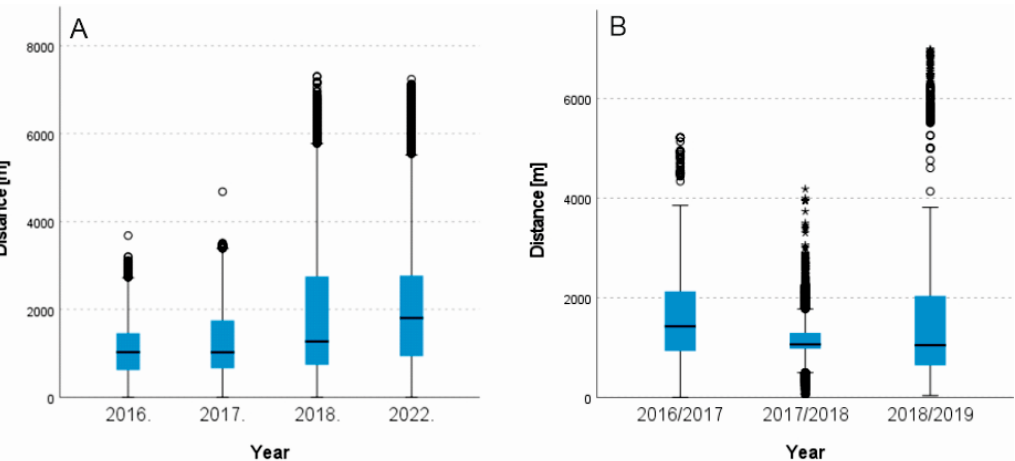
Figure 8. Distance from acclimatisation enclosure in particular summer seasons ( A ) and winter seasons ( B ). Statistically significant differences across all summer seasons, as well as between the winter season 2016/2017 and the other two seasons were observed ( ◦ represents a single observation, * represents extreme outlier).